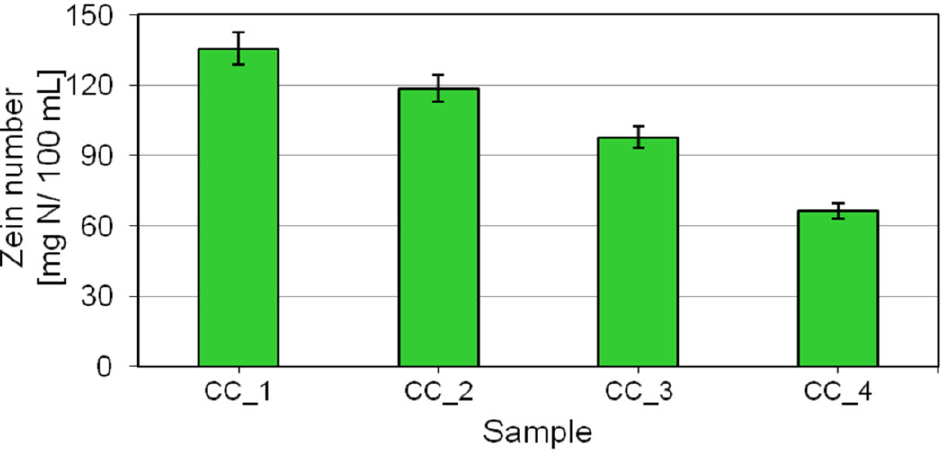
Figure 4. Zein value for shower gels formulated with the digestate extract.